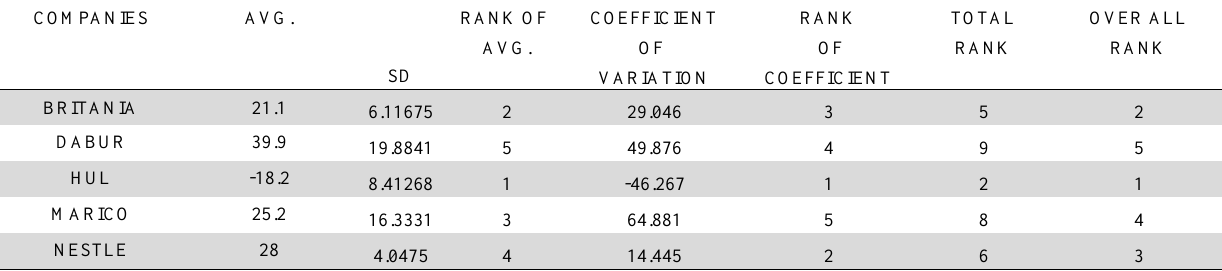
Ranking on the basis of Average and Consistency of Cash conversion Cycle Of the Selected Companies from FMCG Sector